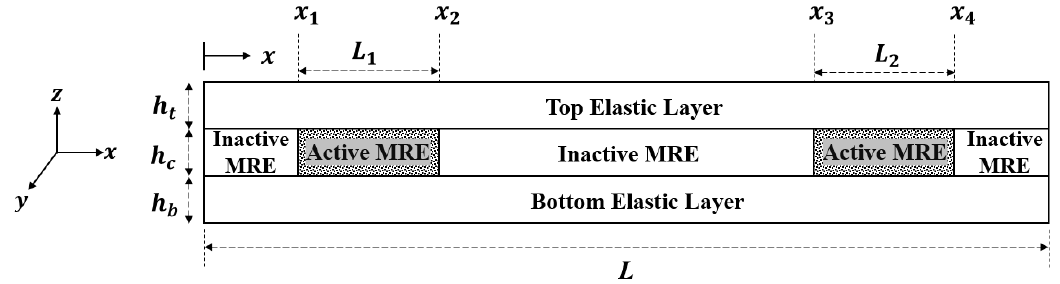
Figure 6. The B–H curve of 1008 steel.